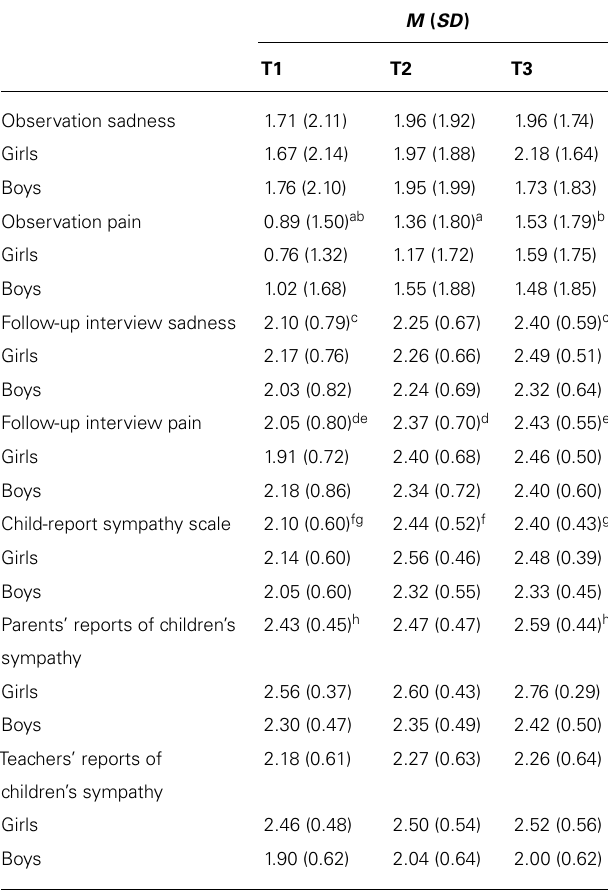
Table 1 | Means and standard deviations of methods measuring